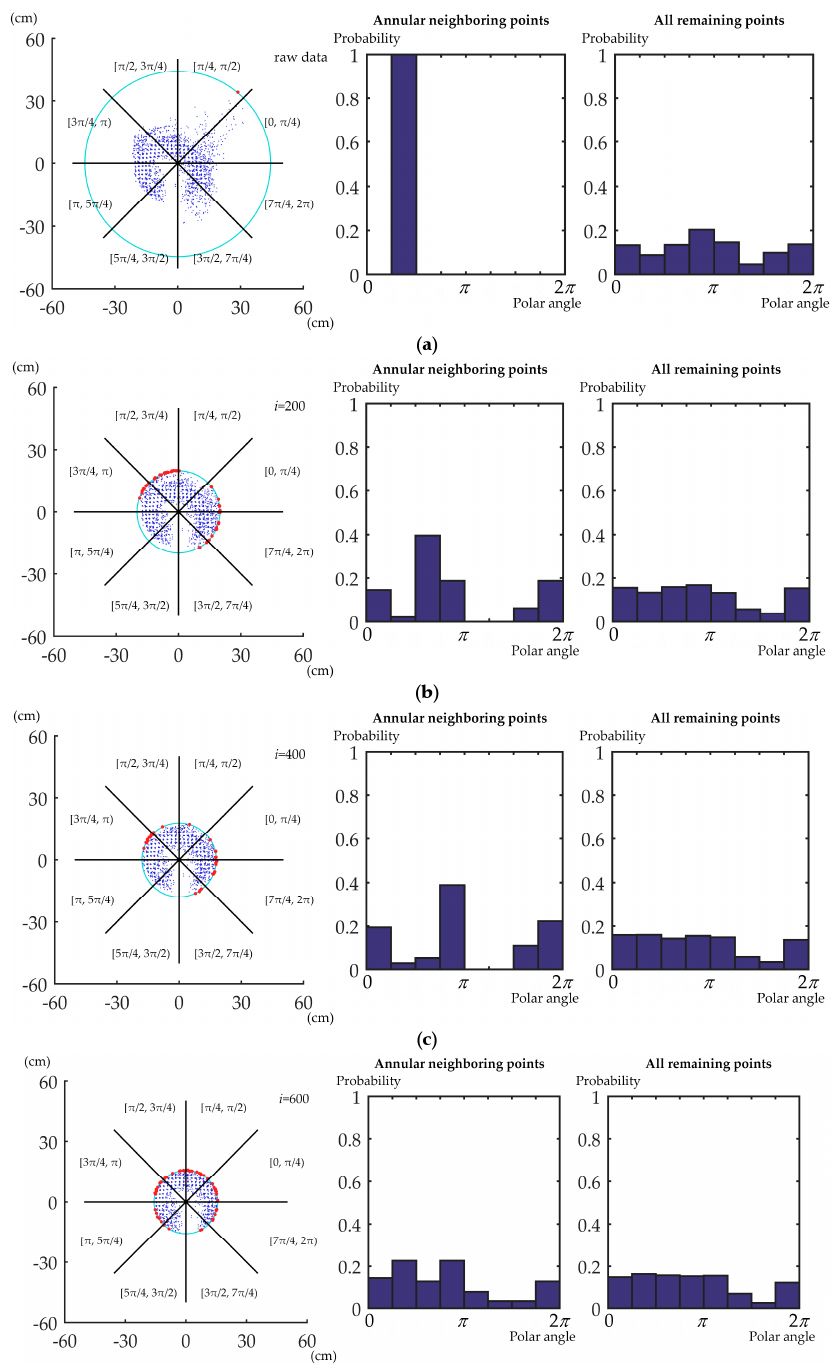
Figure 7. The remaining points and the polar angle distribution of the points within the annular neighborhood and for all remaining points after iteratively removing the outermost points. Points are divided into equal groups based on the polar angle range. The interval of each group is [0, π / 4), [ π / 4, π / 2), ... , [7 π / 4, 2 π ). The cyan rings denote the annular neighborhood, while the red dots denote points located within the annular neighborhood. The parameter i denotes the iteration number of outermost point removal. The details of projected point cloud details are shown in the status of ( a ) raw data, ( b ) i = 200, ( c ) i = 400, and ( d ) i =